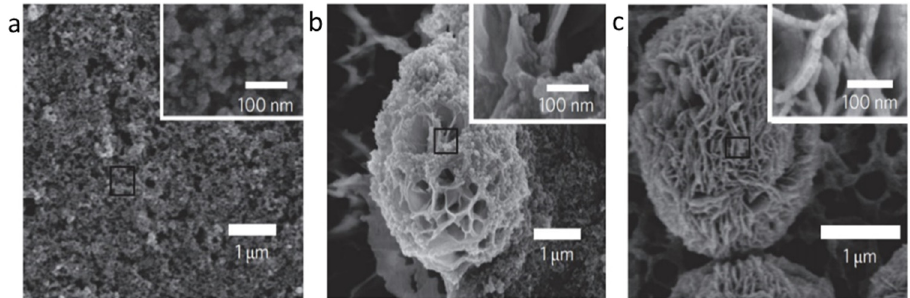
Figure 2. Formation of BSA-Cu 3 (PO 4 ) 2 .3H 2 O nanoflowers. The SEM images at different times: ( a ) 2 h, ( b ) 12 h, and ( c ) 3 days. Reprinted from [20] with permission from Springer Nature. Copyright © 2012, Nature Publishing Group. License Number: 5031780508604.